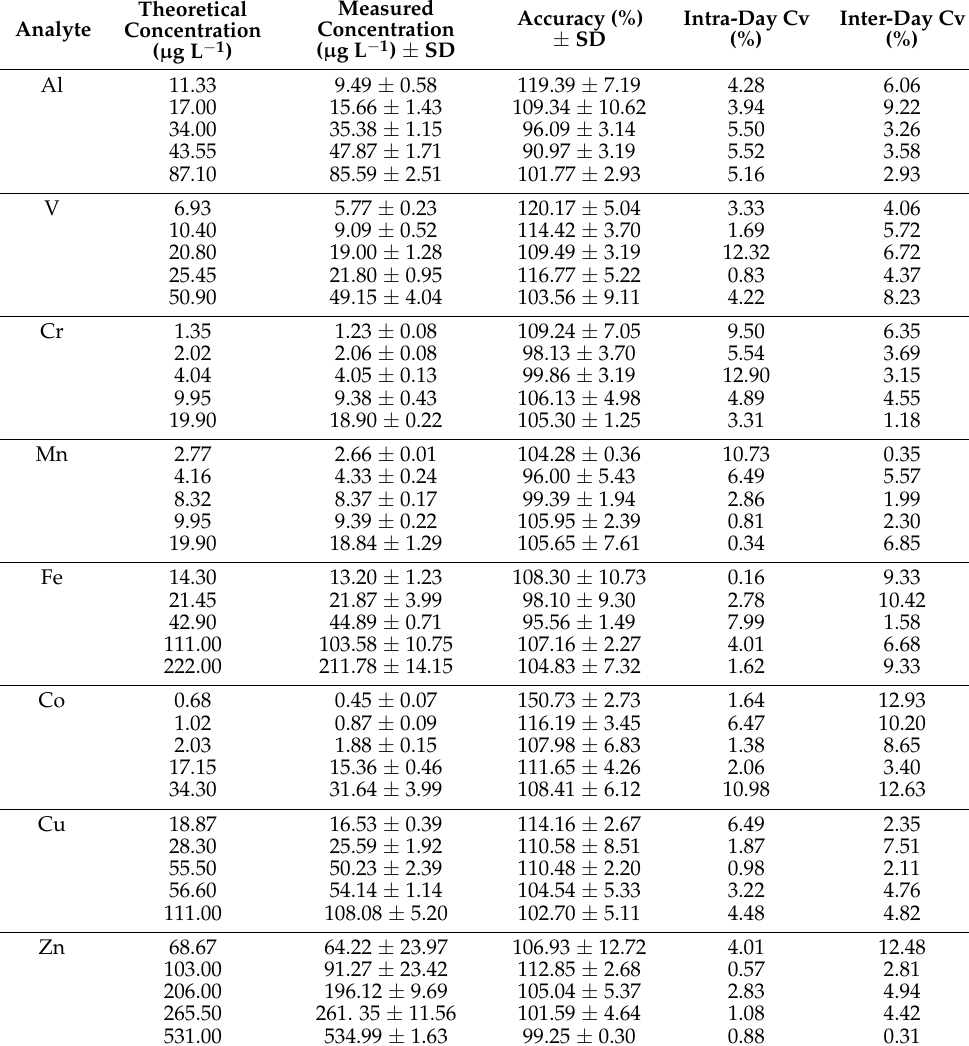
Table 7. Results of the accuracy, intra- and inter-day assay for the validated